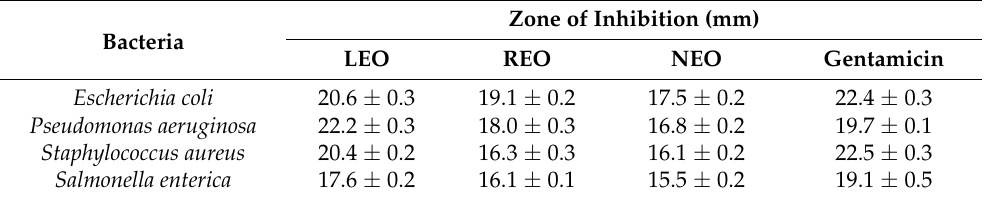
Table 5. Antibacterial activity of Curcuma spp. leaves essential oils evaluated by disc diffusion method.